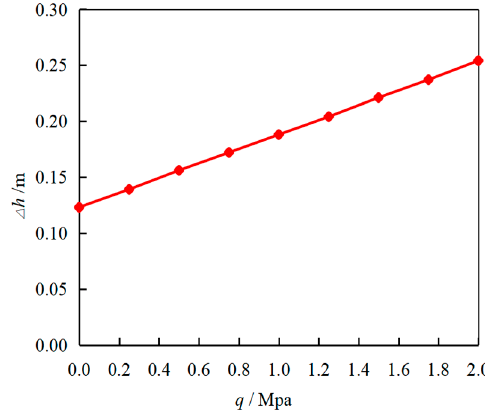
Figure 13. The relationship between step sinking and overburden load. Appl. Sci. 2020 , 10 , x FOR PEER REVIEW